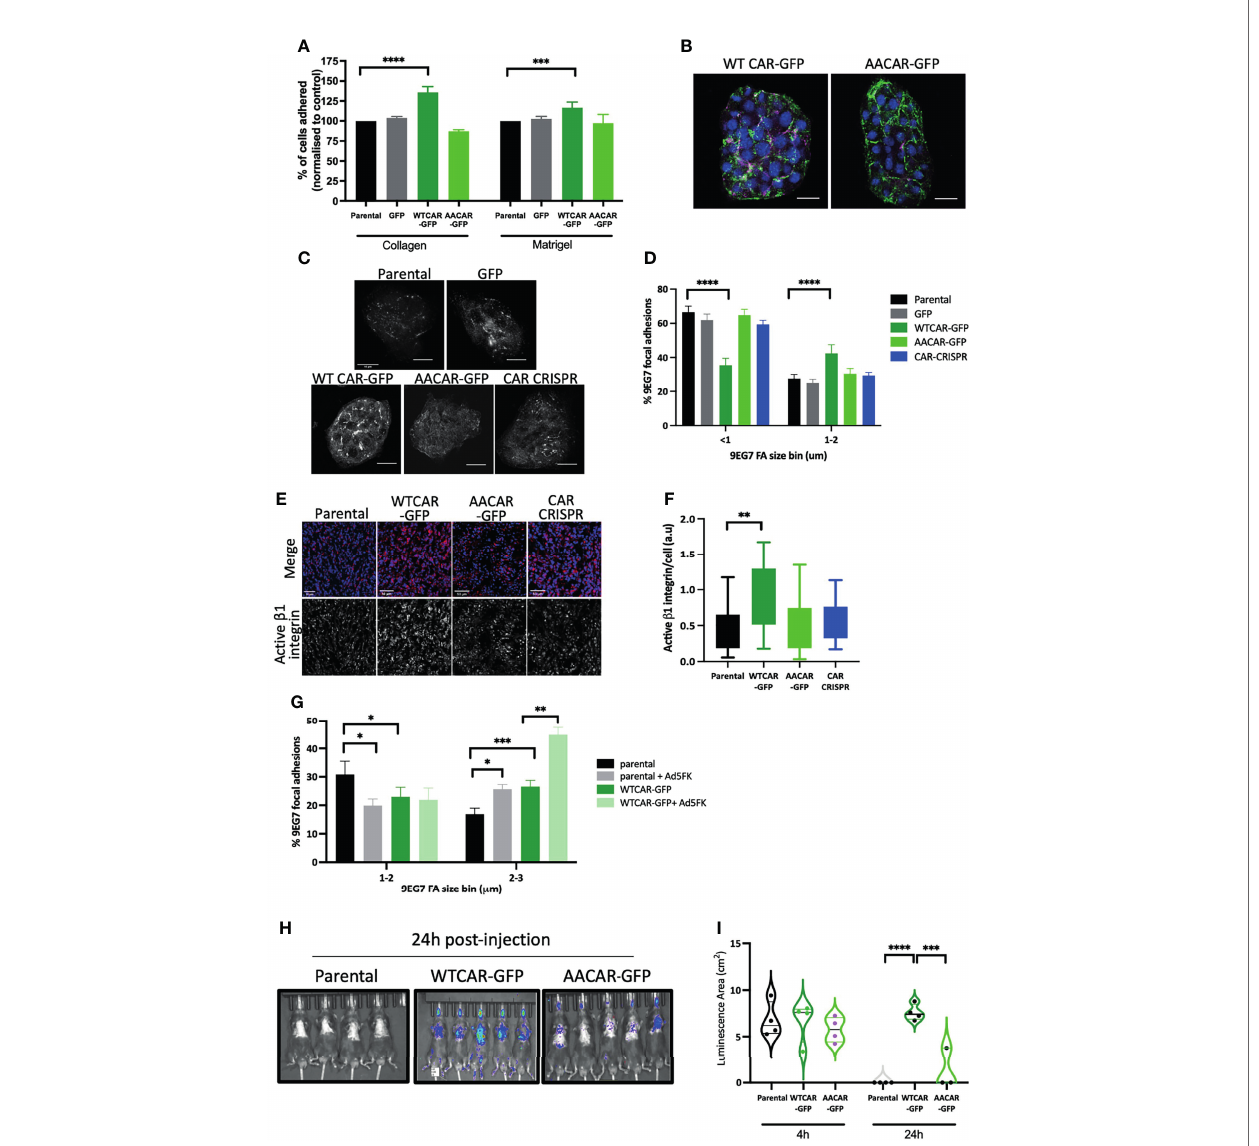
FIGURE 2 | CAR promotes cell-matrix adhesion. (A) Graphs showing % adhesion to collagen and Matrigel of indicated cell lines 2h post-plating. Data is from 3 wells per cell line, representative of 3 independent experiments. (B) Representative confocal images of WTCAR-GFP and AACAR-GFP CMT cells (CAR; green) stained for active b 1 integrins (9EG7; magenta). Scale bars are 20 m m. (C) Representative confocal images of indicated cell lines stained for active b 1 integrins (9EG7). Scale bars are 50 m m. (D) Quanti fi cation of images as in (C) from at least 10 different fi elds of view. Data is presented as % of active integrin adhesions categorised in sizes. Representative of 3 independent experiments. (E) Representative confocal images of tissues from subcutaneous tumors of indicated cell lines, stained for active integrins (9EG7, red) and DAPI (blue). Scale bars are 50 m m. (F) Quanti fi cation of images as shown in (D or E)?. Data is from 6 tumors per cell line, and 4 fi elds of view per tumor. (G) Quanti fi cation of 9EG7 staining as in (B,C what about 9eg7 fk images)? from parental or WTCAR-GFP cells with or without Ad5FK pre-incubation. Data is from at least 10 different fi elds of view per condition. Data is presented as % of active integrin adhesions categorised in sizes. Representative of 3 independent experiments. (H) Images of indicated cell lines expressing luciferase 24 hours after intravenous injection into animals. Representative of 2 independent experiments. (I) Quanti fi cation of data as in (H) Violin plots shown with each point represents one animal (n=4-5 per group). All values are mean ± SEM. P values *p < 0.05,**p < 0.01, ***p < 0.0005, ****p <